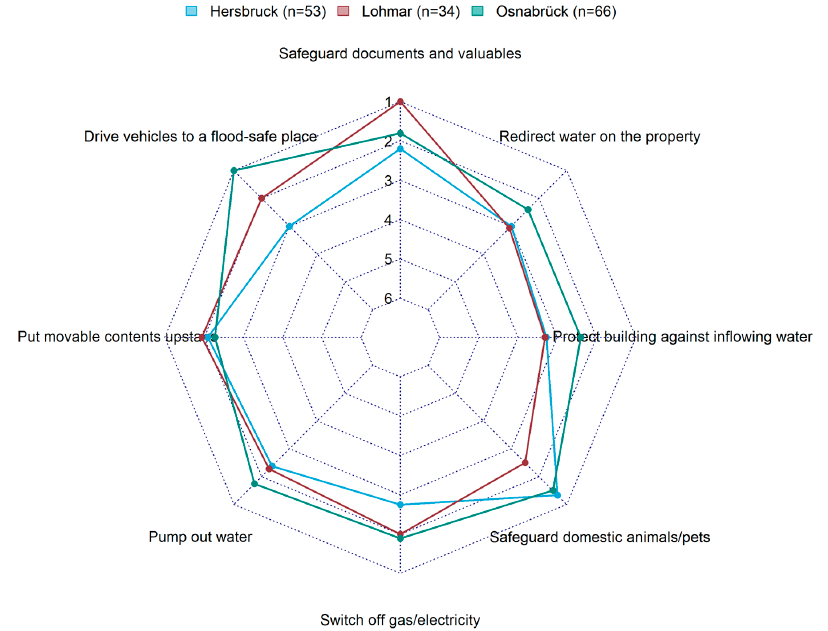
Figure 6. Average effectiveness on a scale from ( 1 ) “very effective” to ( 6 ) “not at all effective”, evaluated by the respondents for each implemented measure. Data are shown for each study area. Table 4. Contingency table showing the number of respondents by implemented emergency measures and received warning (EM: emergency